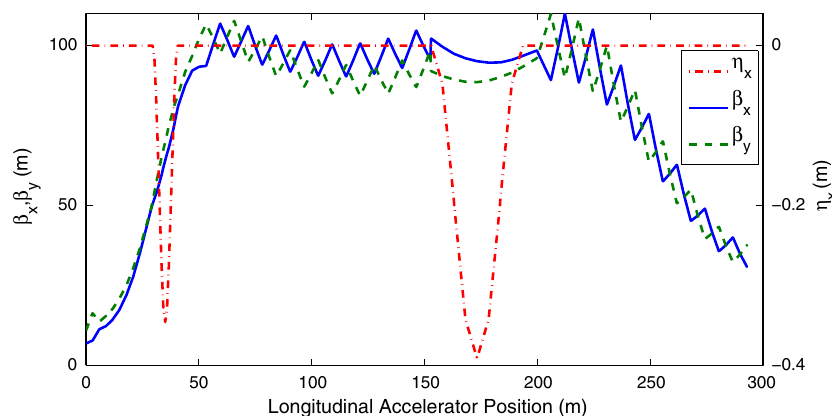
FIG. 3. Courant-Snyder parameters for 3D ELEGANT simulations showing (cid:2) functions (solid and dotted lines) and dispersion , dash-dotted line). The weak second chicane is designed to minimize ISR effects. Following the second chicane, a third linac ( (cid:7) x section increases the electron energy while simultaneously decreasing the (cid:2) function, enhancing the radiation